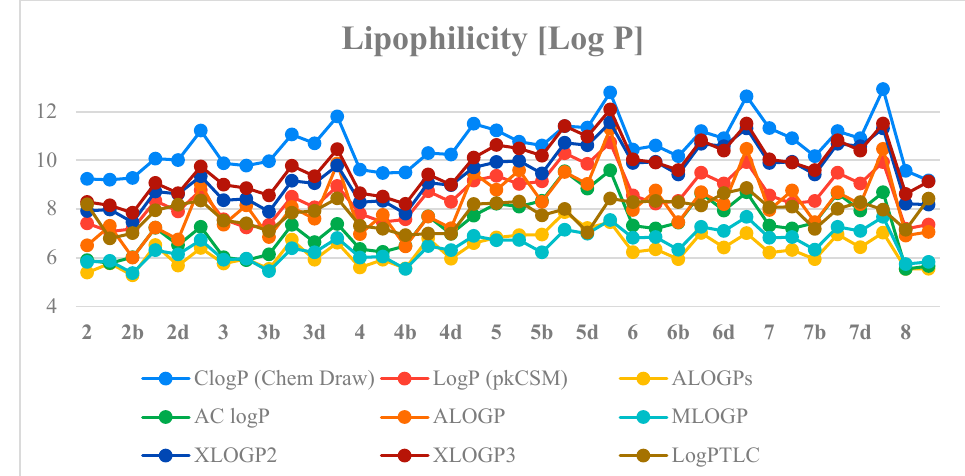
Figure 5. The profile of change for calculated and experimental lipophilicity of the studied com- Figure 5. pounds. studied compounds. Table 9. The pharmacokinetic parameters of tested compounds (pkCSM-Biosig Lab—University